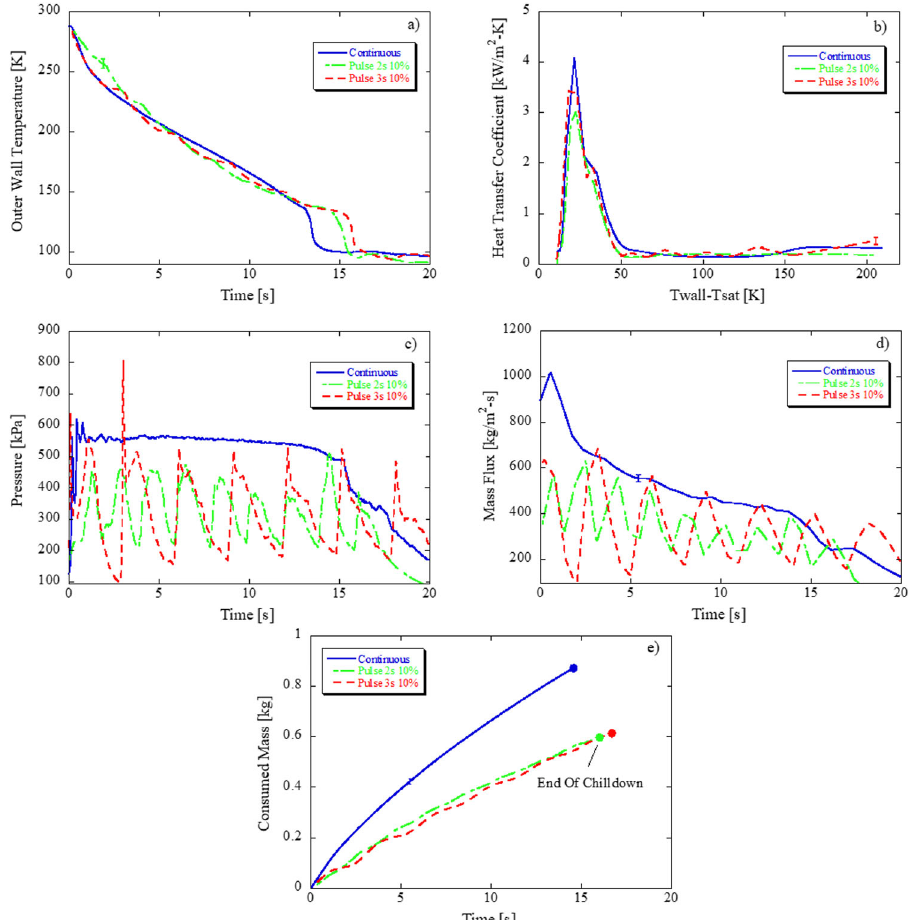
Fig. 3 Effect of pulse fl ow on a bare tube in microgravity: 550 kPa source pressure, bare tube surface, 0.05 G level (g/g0) — F2 (Flight_Day1_2, 67324 Re, continuous) versus F3 (Flight_Day1_3, 53859 Re, pulse 2 s 10%) versus F4 (Flight_Day1_4, 64092 Re, pulse 3 s